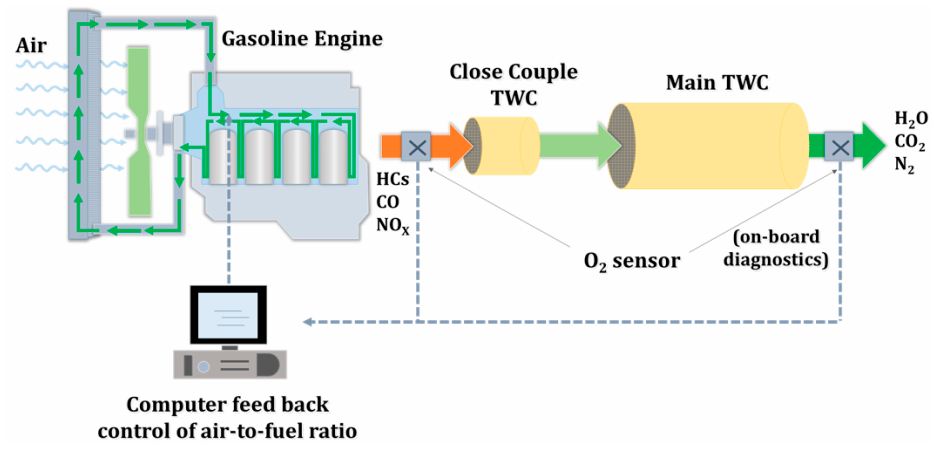
Figure 3. A schematic of the unit operations in the exhaust system for a TWC with feed back control of air-to- fuel ratio